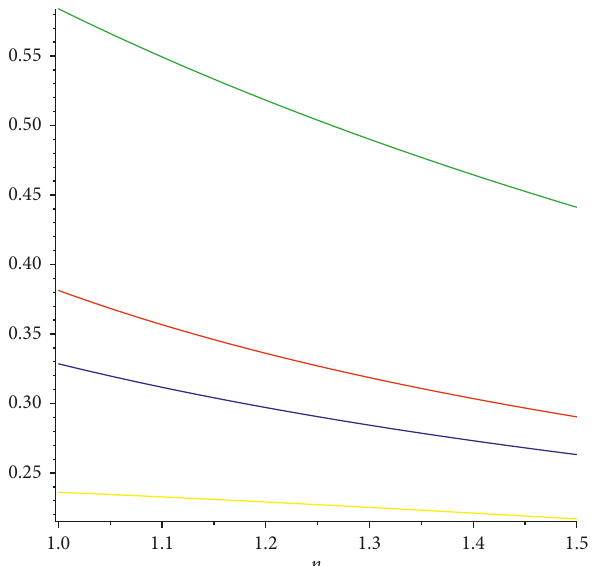
Figure 8: IR2 of D